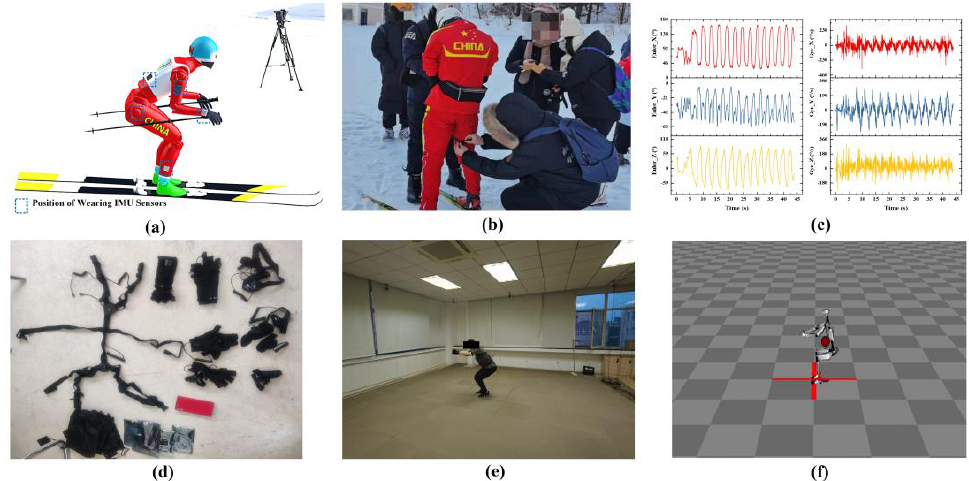
Figure 6. The cross-country skiing dataset and sample image display. ( a ) shows the outdoor dataset collection method. ( b ) shows the sensor worn by the experimental personnel. ( c ) shows outdoor sensor data. ( d ) shows the indoor dataset acquisition mode. ( e ) shows the indoor dataset acquisition process. ( f ) shows the result of the indoor dataset.